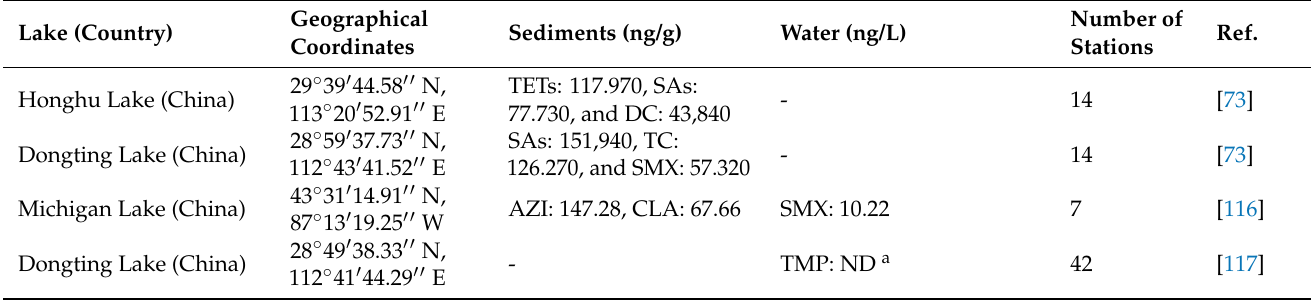
Table 4. Studies on antibiotics in the sediments and water of